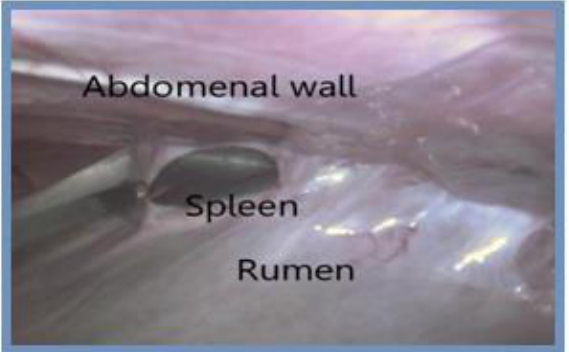
Figure, 7: The adhesion between spleen, abdominal wall and rumen at 30 days in goat group A.